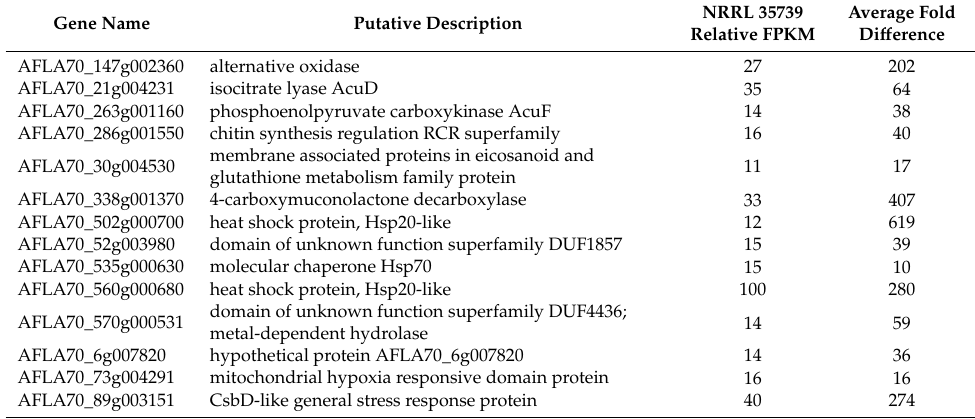
Table 4. Genes with di ff erential relative expression of interest in the A. flavus AF70 alignment.